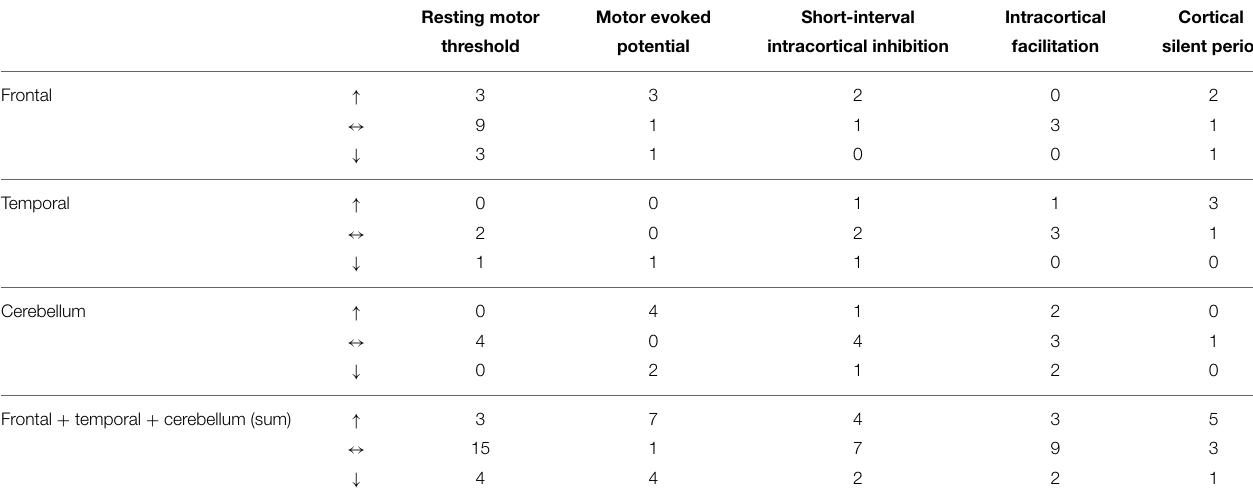
TABLE 3 | Number of different measures of motor cortex excitability with increases, no changes (null findings), and decreases with respect to the different stimulation